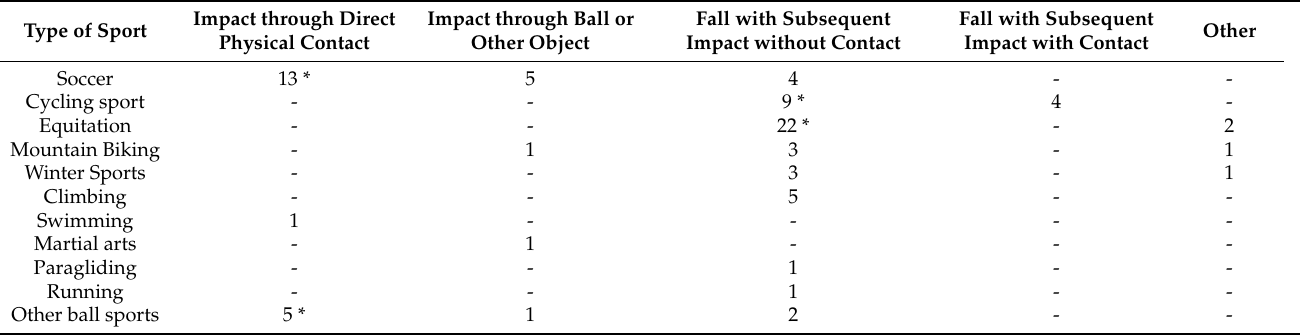
Table 1. Distribution of sports-related concussions (SRC) by type of sport and injury mechanism, n =